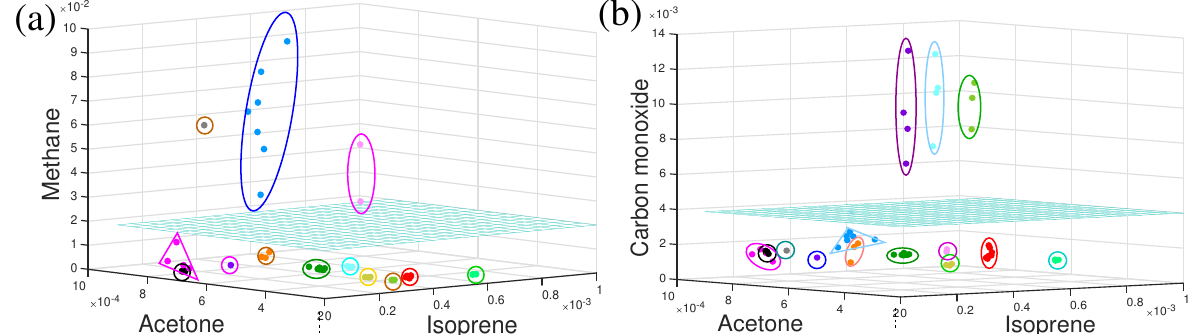
Figure 5. The three-dimensional component space representation of VOCs for healthy volunteers. Each enclosed cluster of points represents data from a single volunteer. The cyan colour horizontal plane separated ( a ) methanogenic and non-methanogenic volunteers and ( b ) smoker and non-smoker volunteers.